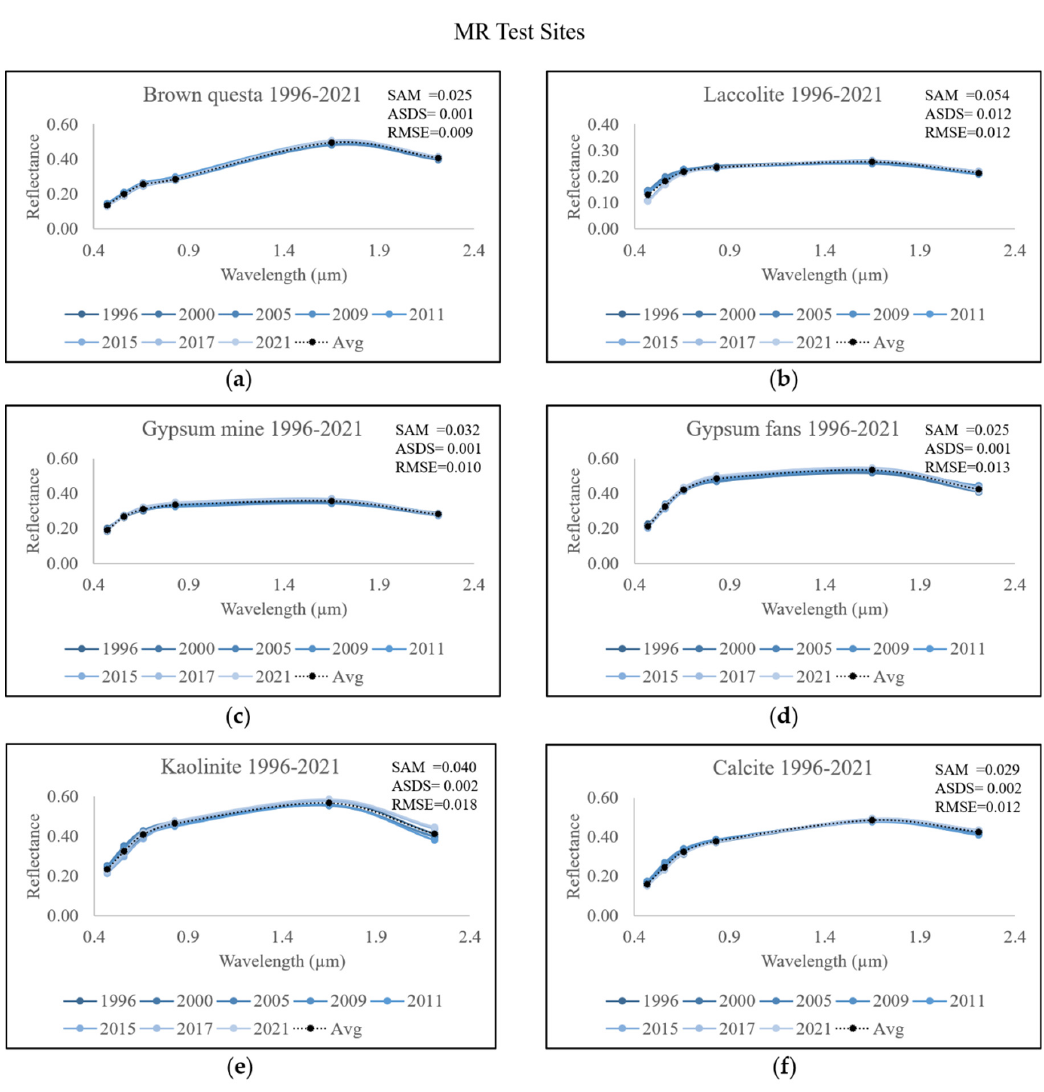
Figure 7. Examination of spectral changes at MR VAL test sites: LANDSAT reflectance signal for each year (1996–2021): ( a ) brown questa; ( b ) laccolite; ( c ) gypsum mine; ( d ) gypsum fans; ( e ) kaolinite; ( f ) calcite. The mean value is marked by black dashed lines.